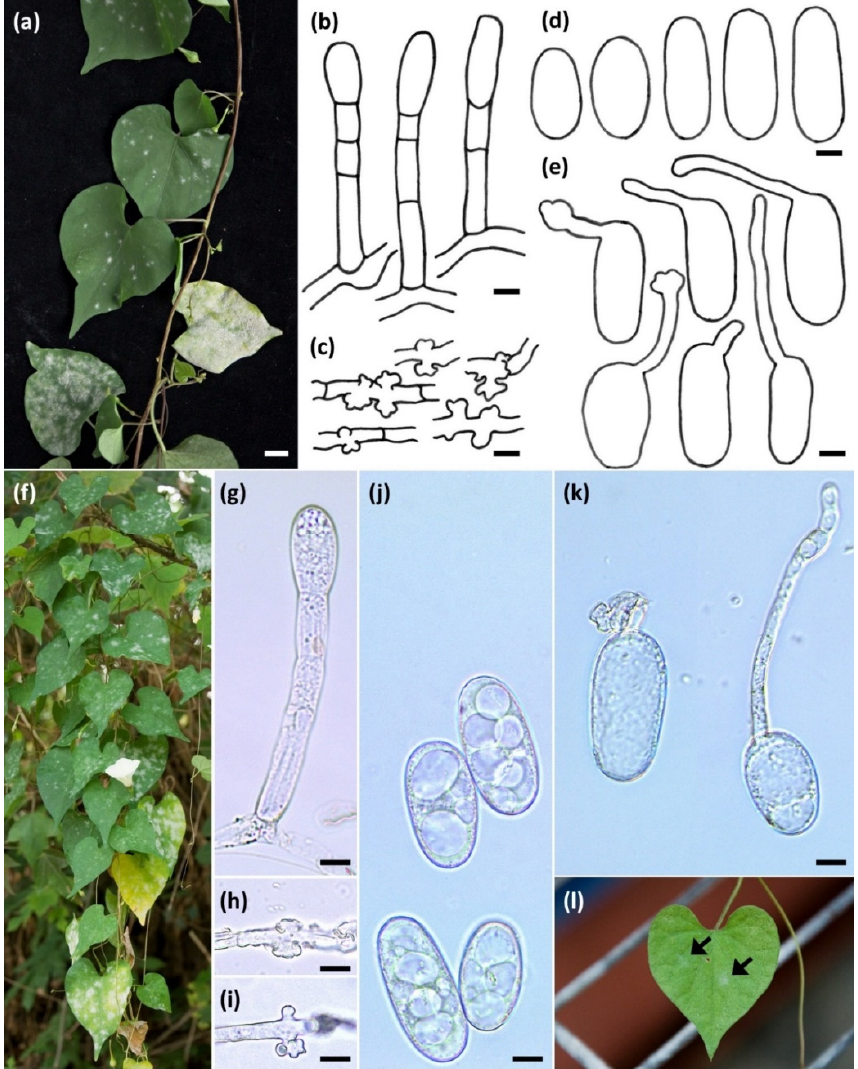
Figure 3. Erysiphe ipomoeae on Ipomoea obscura . ( a ) Symptoms of E. ipomoeae on I. obscura , TNM 0035015, neotype. ( b – e ) Drawings showing microscopic characteristics of TNM 0035015. ( b ) Conidiophores with conidia. ( c ) Hyphal appressoria. ( d ) Conidia. ( e ) Conidia with germ tubes. ( f ) Symptoms of the powdery mildew on naturally infected plant in field. ( g – k ) Micrographs of E. ipomoeae on I. obscura TNM 0035015. ( g ) Conidiophore with conidium. ( h , i ) Hyphal appressoria. ( j ) Conidia. ( k ) Conidia with germ tubes. ( l ) The symptoms on I. obscura inoculated with E. ipomoeae on I. obscura . Scale